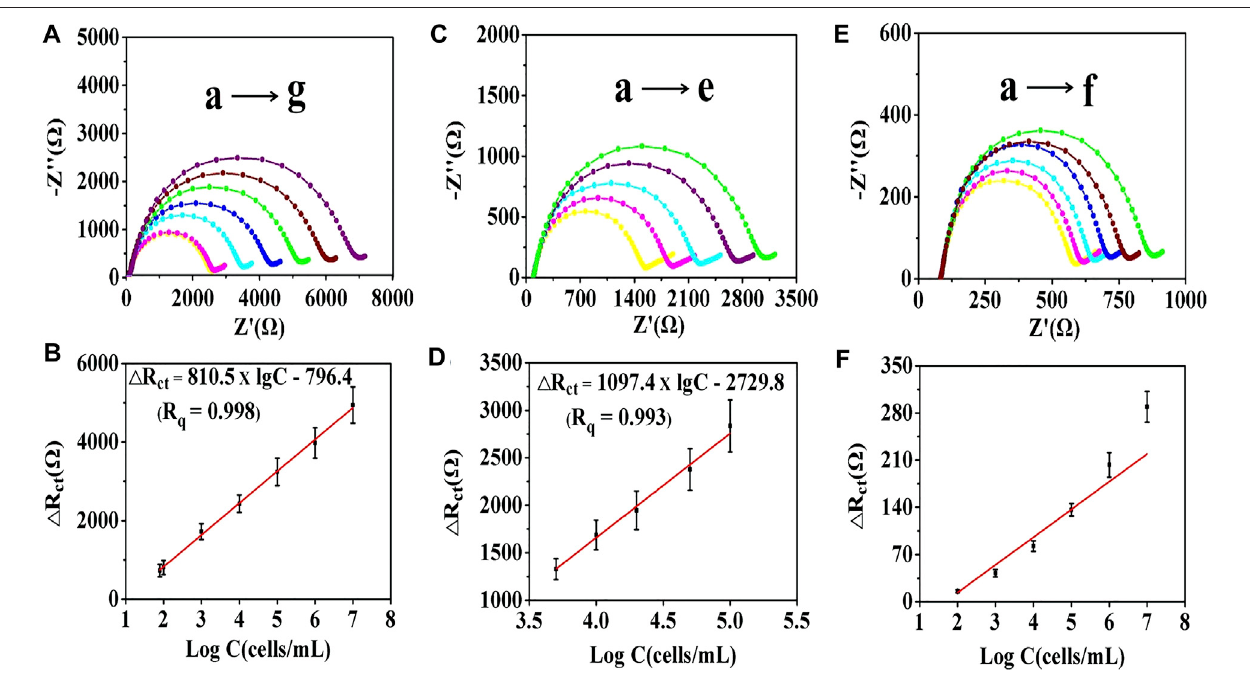
FIGURE 5 | EIS curves of the cell sensors after capturing different concentrations of 4T1 cells. (A) EIS curves of the G0 cytosensor. (B) linear relationship between theimpedancevalueoftheG0cytosensorandthelogarithmofcellsconcentration:(a)8.0 × 10,(b)1.0 × 10 2 ,(c)1.0 × 10 3 ,(d)1.0 × 10 4 ,(e)1.0 × 10 5 ,(f)1.0 × 10 6 ,and(g) 1.0 × 10 7 cells/mL. (C) EIS curves of the G0/GCE electrode. (D) linear relationship between the impedance value of the G0/GCE electrode and the logarithm of cells concentration: (a) 5.0 × 10 3 , (b) 1.0 × 10 4 , (c) 2.0 × 10 4 , (d) 5.0 × 10 4 , and (e) 1.0 × 10 5 cells/mL. (E) EIS curves of the GCE electrode and (F) linear relationship between the impedance value of the GCE electrode and the logarithm of cells concentration: (a) 1.0 × 10 2 , (b) 1.0 × 10 3 , (c) 1.0 × 10 4 , (d) 1.0 × 10 5 , (e) 1.0 × 10 6 , and (f) 1.0 × 10 7 cells/mL. The error bars represent the standard deviation of three independent measurements.